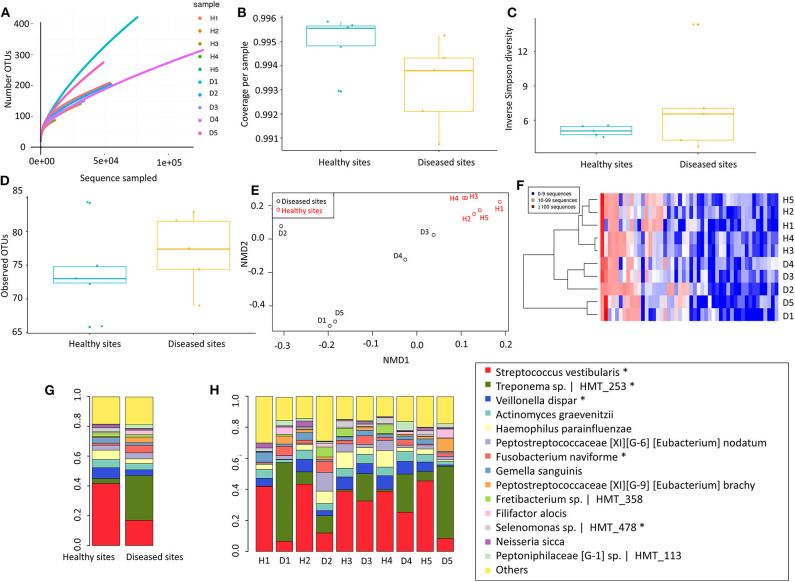
Microbiome of gingival tissues from healthy and diseased sites. (A) Rarefaction curve for the number of OTUs as a function of sampling effort. (B) Sample coverage. (C) Inverse Simpson diversity. (D) Observed OTU per group. (E) Non-metric multidimensional scaling (NMDS) for distance matrix of between disease and healthy samples. (F) OTU abundance across samples_ Abundant OTUs only (after removing rare OTUs). The bacterial relative abundance of the gingival tissue in (G) all healthy and disease tissues, or in (H) individual gingival tissues. The abundance that significant shift (P < 0.05) between two sites were highlighted in “*”. Healthy sites: H. Diseased sites: D.